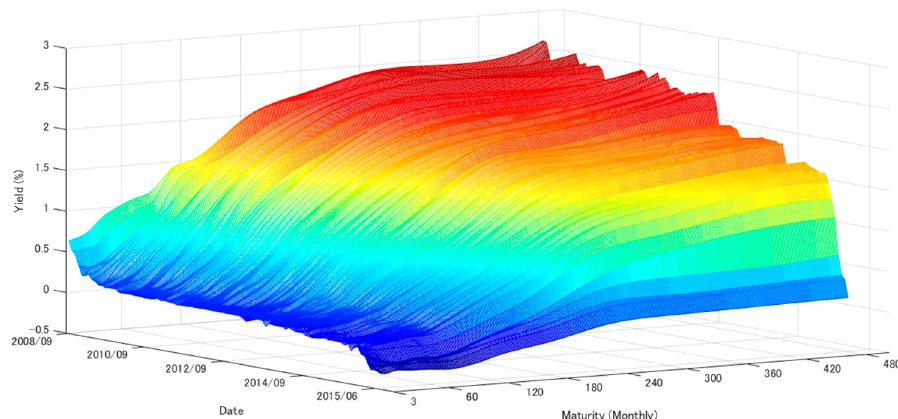
Figure 1. Japanese government bond zero-coupon yield curve (2008 / 09–2015 / 06). Note: Figure 1 plotted the Japanese government bond zero-coupon yield curve. We used the yields of maturities of 3, 6, 12, 24, 36, 48, 60, 72, 84, 96, 108, 120, 180, 240, 300, 360, and 480 months, and the term was from September 2009 to June 2015 monthly data. To calculate the zero-yield of the Japanese government bond, the treasury bill and the prevailing interest rates, which are published by the Japanese Ministry of Finance were used. To interpolate of the missing maturities, the cubic spline was used.